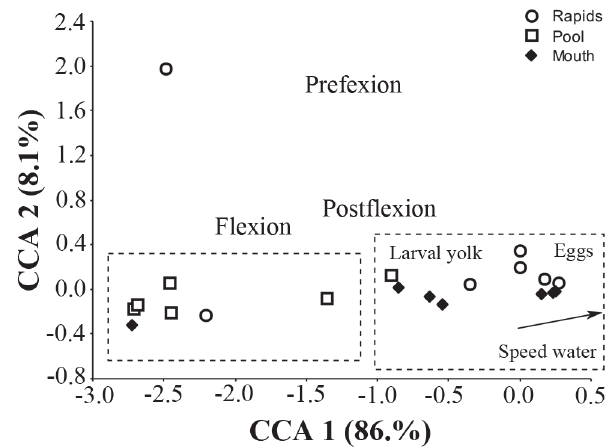
Fig. 7. Biplot resulting from Canonical Correspondence Analysis related to the abundance of the different stages of ichthyoplankton found in three locations of the Ligeiro River (rapids, pool, and mouth) from September 2006 through March